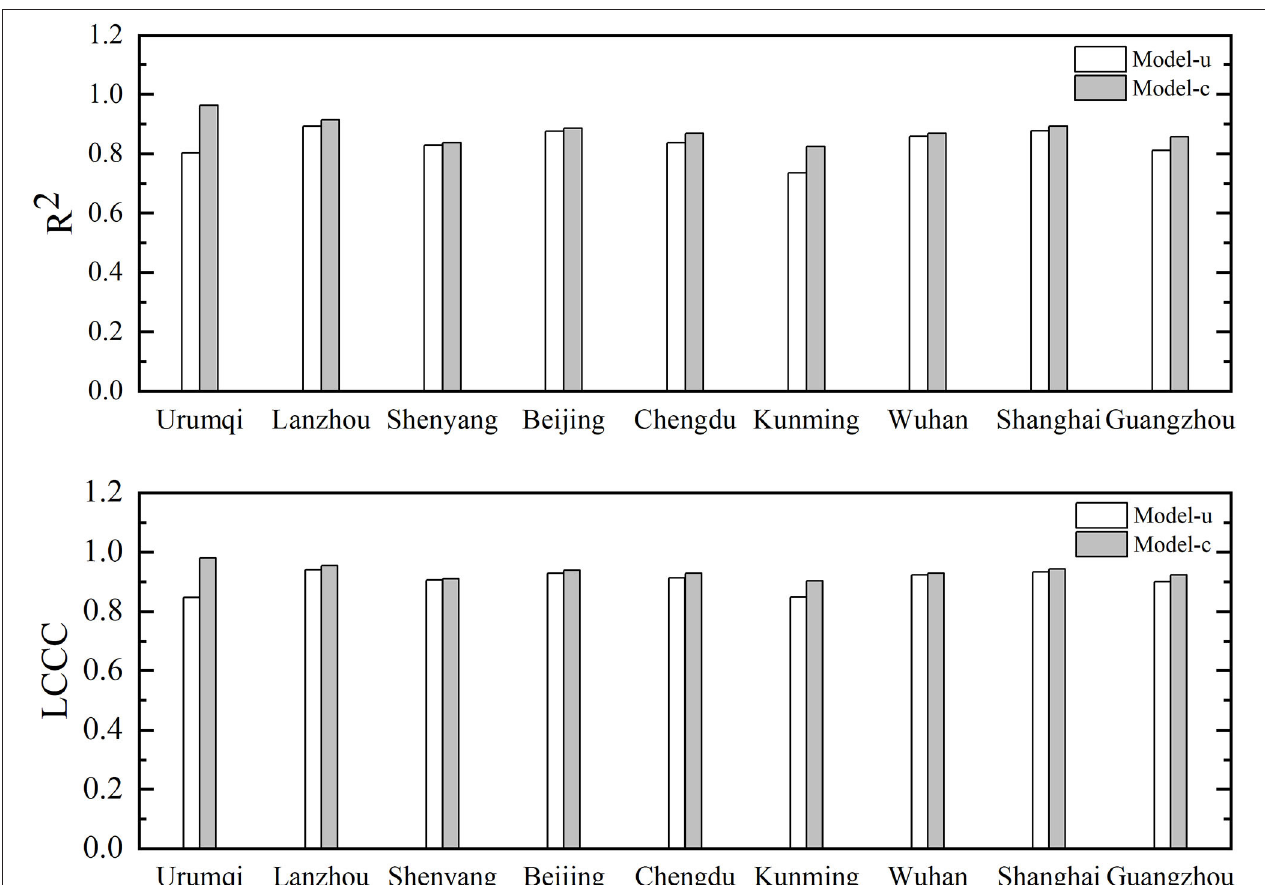
FIGURE 7 | Comparison of R 2 and LCCC values between the two